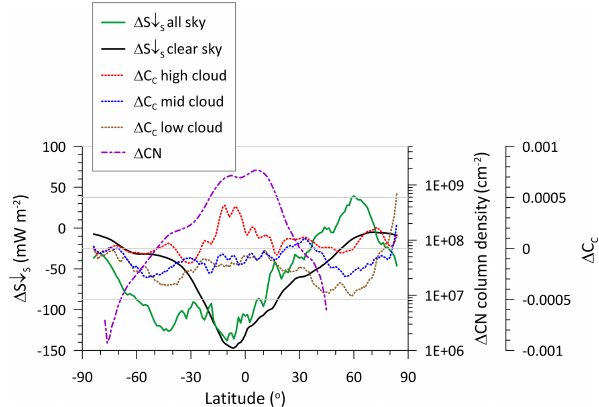
Figure 6. Zonal mean (2006–2010) of parameter value differences between the model run with both the new oceanic O 3 dry deposition scheme and the new lightning flash-rate parameterisation and the base model run (Run C – base): all-sky downward shortwave radia- tive flux difference at the surface ( (cid:49)S ↓ S ); clear-sky (cid:49)S ↓ S ; differ- ences in high, medium and low cloud cover ( (cid:49)C C ); and column in- tegrated condensation nuclei (CN) concentration difference ( (cid:49) CN). The lines are running averages (over a moving window of ten points, i.e. 12.5 ◦